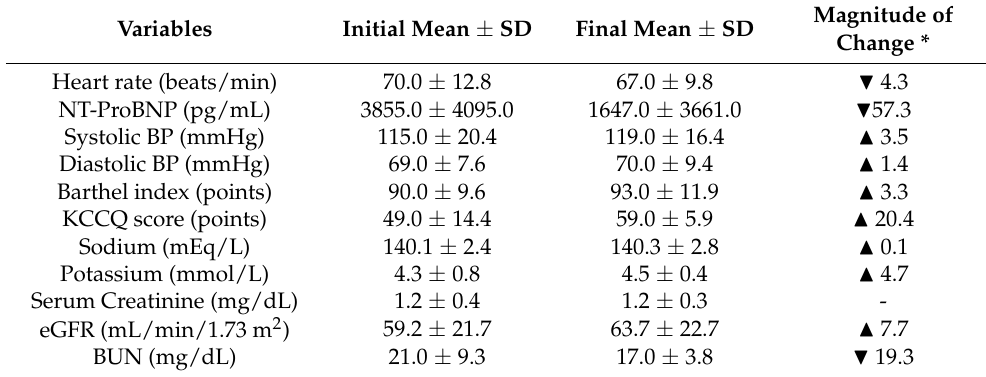
Table 2. Comparison of the main clinical parameters before and after the establishment of the SGLT2 inhibitor. Abbreviations: BUN, blood urea nitrogen; BP, blood pressure.